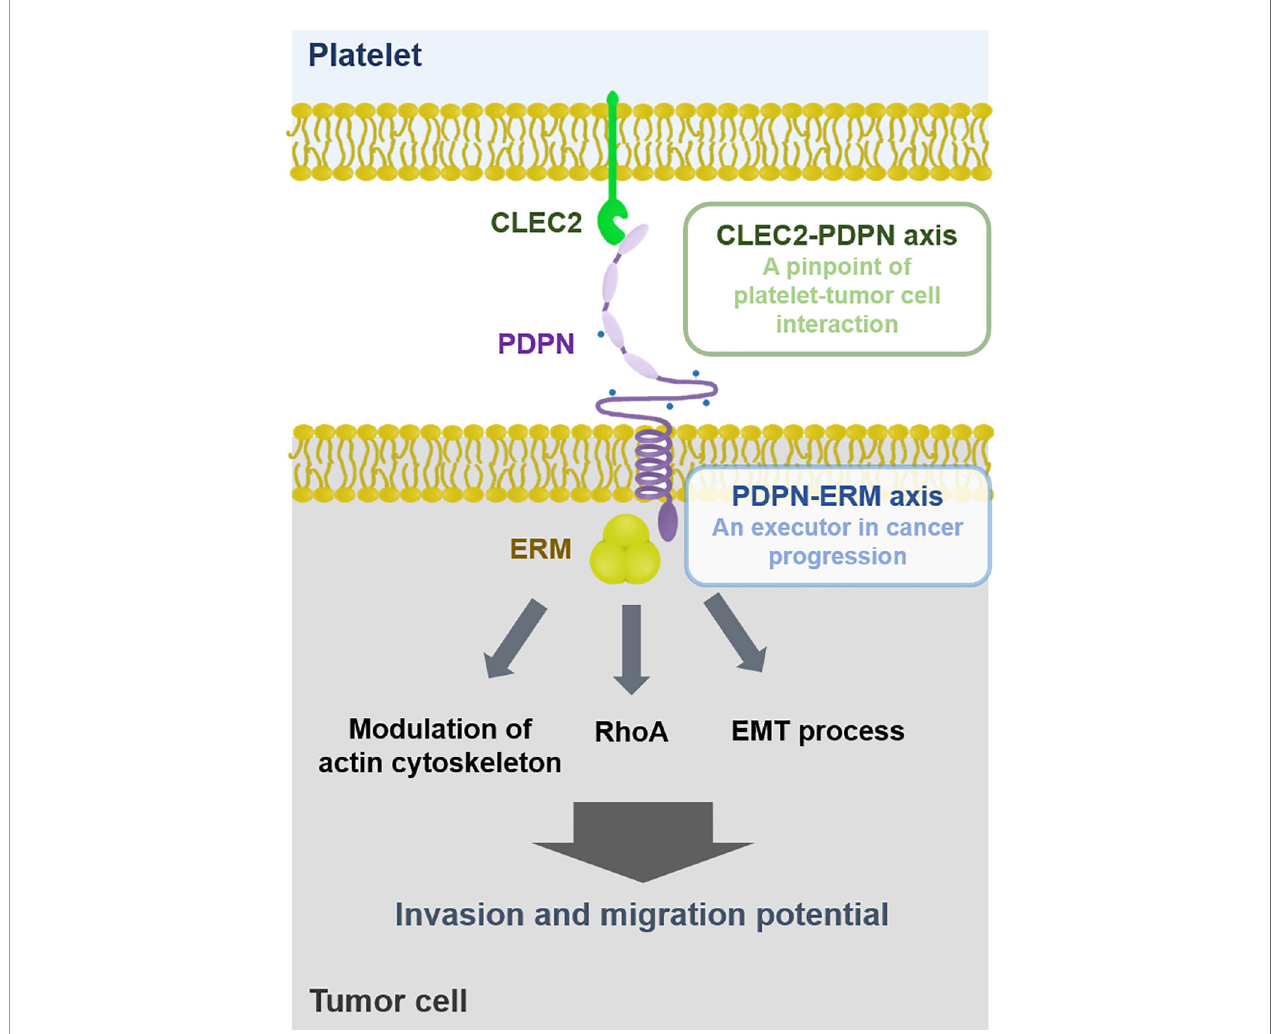
FIGURE 1 | Interaction between platelet and tumor cell. Platelets can physically interact with tumor cells via the CLEC2-PDPN axis. PDPN is associated with ERM proteins that promote cancer cell migration and invasion through modulating actin cytoskeleton, RhoA, and EMT process. Thus, the CLEC2-PDPN-ERM axis is a crucial target for